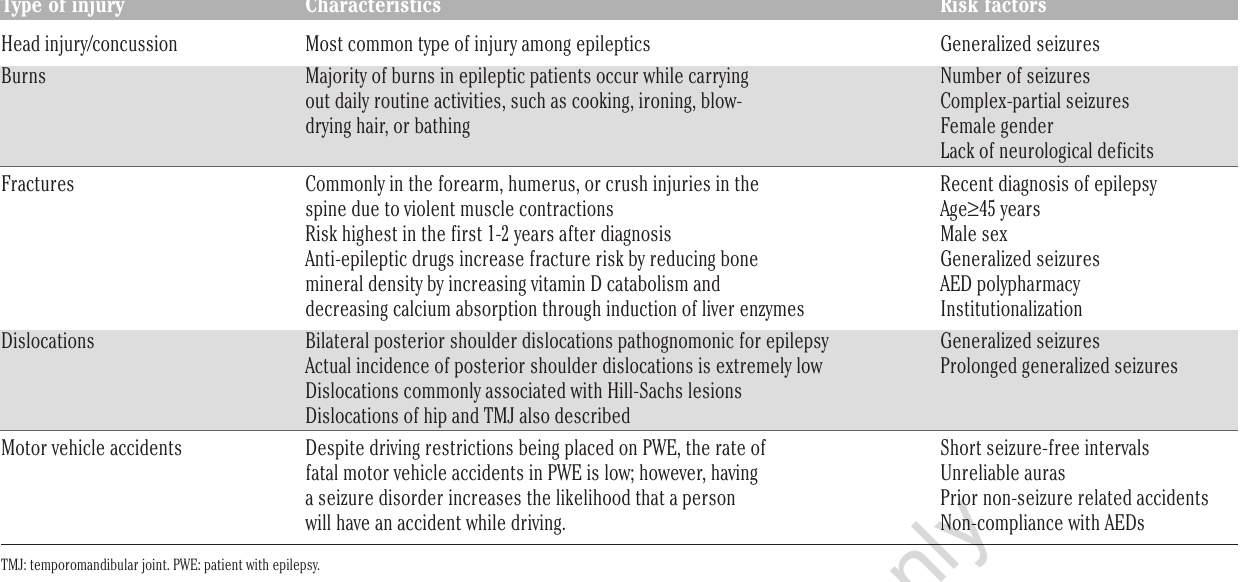
Table 3. Characteristics of common injuries associated with epilepsy. Type of injury